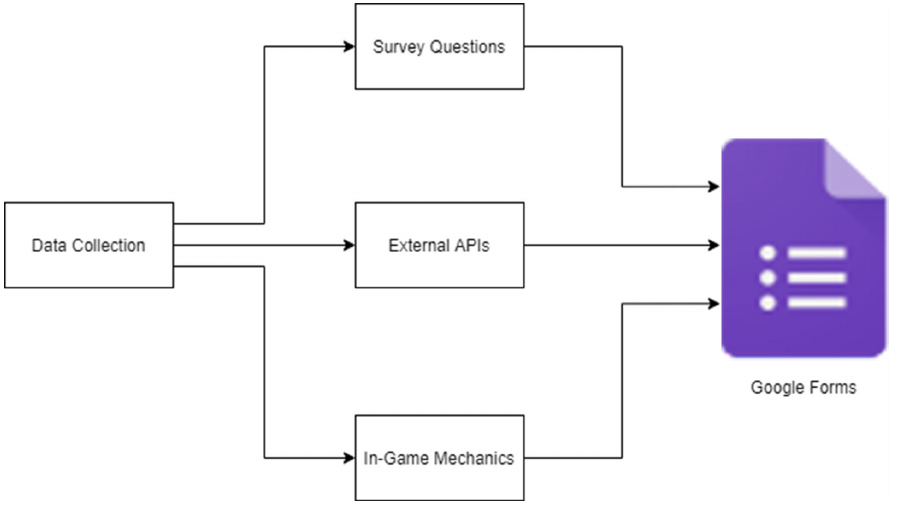
Figure 11. The schematic explains unified participant data collection from multiple sources (surveys, external APIs, in-game